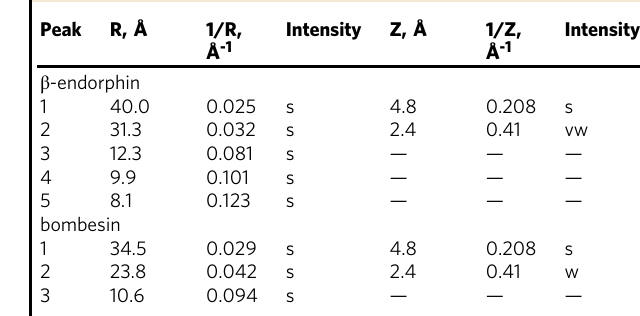
Table 1 Positions and qualitative intensities of diffraction